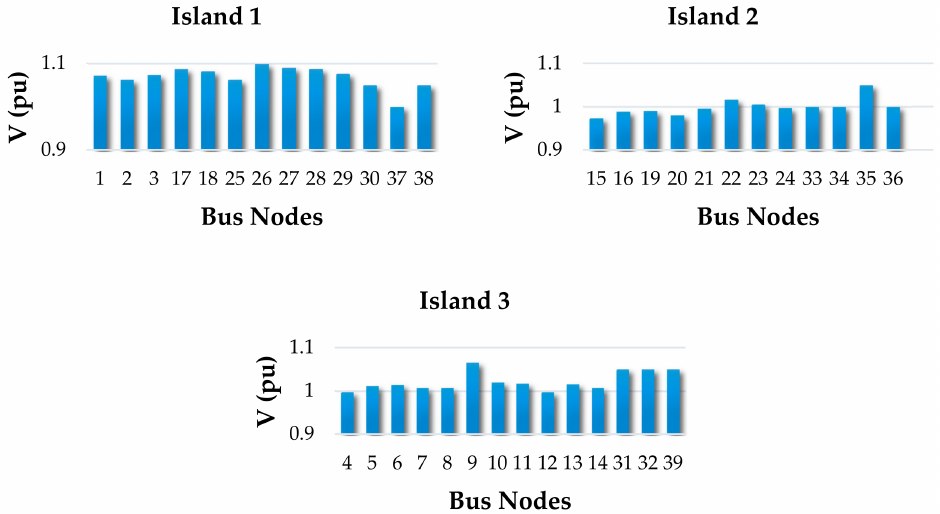
Figure 7. IEEE 39-bus voltage profile for the optimal three